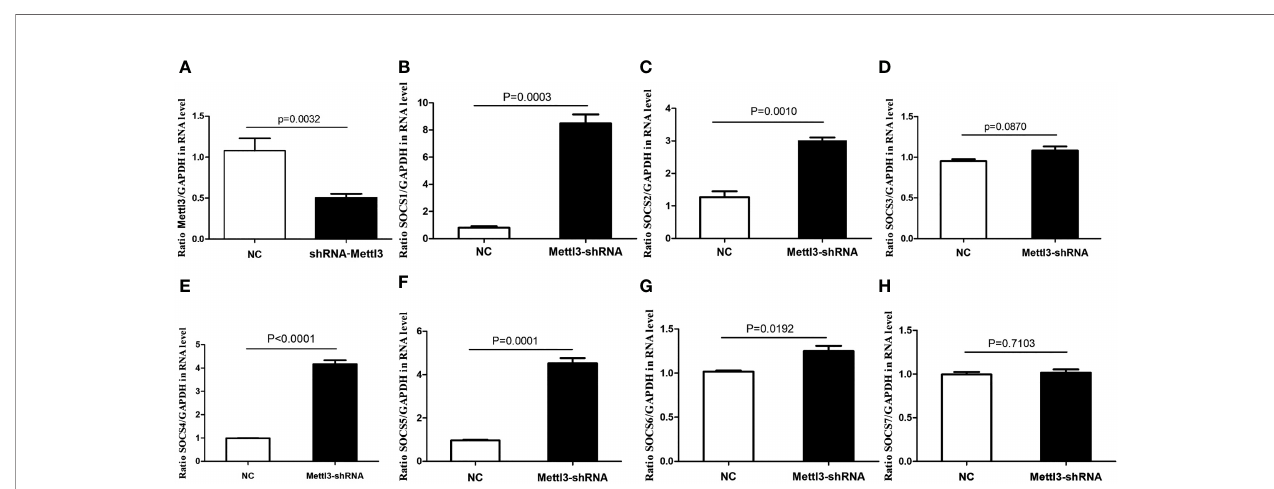
FIGURE 6 | mRNA expressions of SOCS family members in METTL3 knock-down RAW 264.7 cells. (A) It showed the signi fi cant lower expression of METTL3 after METTL3 knock-down; (B) SOCS1 mRNA expression after METTL3 knock-down; (C) SOCS2 mRNA expression after METTL3 knock-down; (D) SOCS3 mRNA expression after METTL3 knock-down; (E) SOCS4 mRNA expression after METTL3 knock-down; (F) SOCS5 mRNA expression after METTL3 knock-down; (G) SOCS6 mRNA expression after METTL3 knock-down; (H) SOCS7 mRNA expression after METTL3